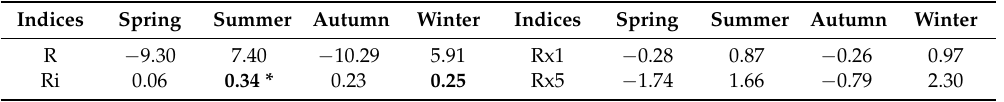
Table 3. Changing trends for the regional mean R (mm · season − 1 · decade − 1 ), Ri (mm · day − 1 · decade − 1 ),